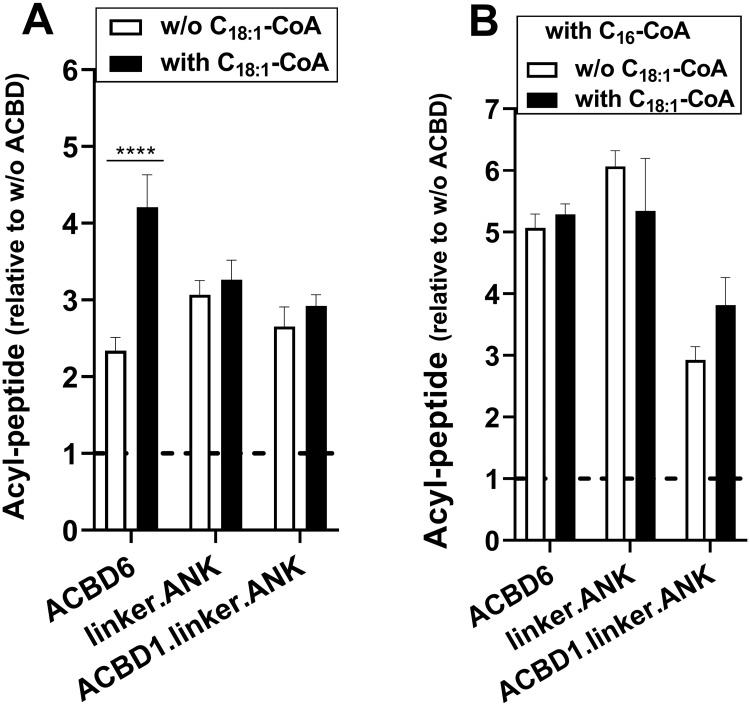
Acyl-CoA binding to the ACB domain enhances NMT2 activity.Formation of the myristoyl-peptide by NMT2 (50nM) was measured in the presence of the indicated proteins (4μM) and with 5μM C14-CoA. As indicated, C16-CoA (50μM) and C18:1-CoA (20μM) were added in the reactions. Control reactions were performed in the absence of the ACBD constructs and the data are presented relative to the values obtained in their absence. Error bars represent the standard deviations of values obtained from three reactions. **** indicate a p value of <0.0001. Differences detected with the linker.ANK and ACBD1.linker.ANK forms did not reach statistical significance of p ≤0.05.